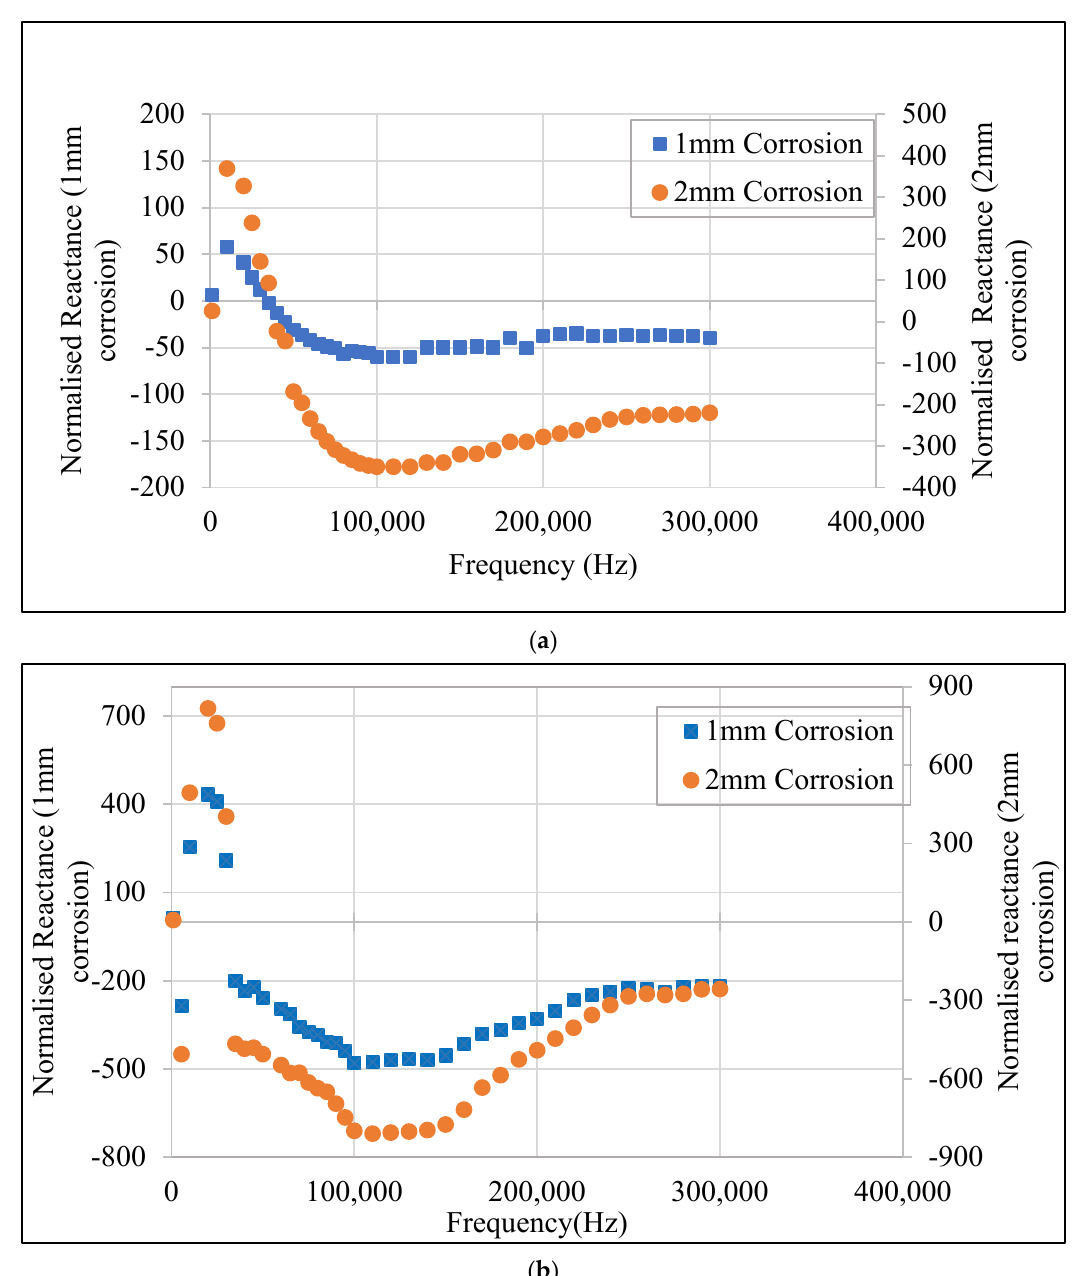
Figure 10. ( a ) The FE modelling normalized reactance for 1 mm and 2 mm corrosion in 8 mm thick plate. ( b ) The normalized reactance variation for 1 mm and 2 mm uniform corrosion in 8 mm thick plate obtained from experimental studies.